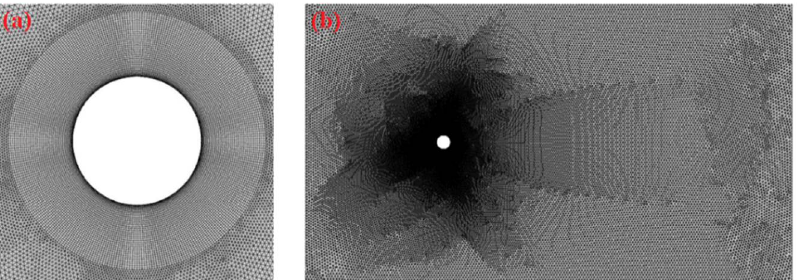
Figure 5. Discretization of the computational domain ( a ) close-up of the meshes near the cylinder; ( b ) Mesh division of the computational domain.